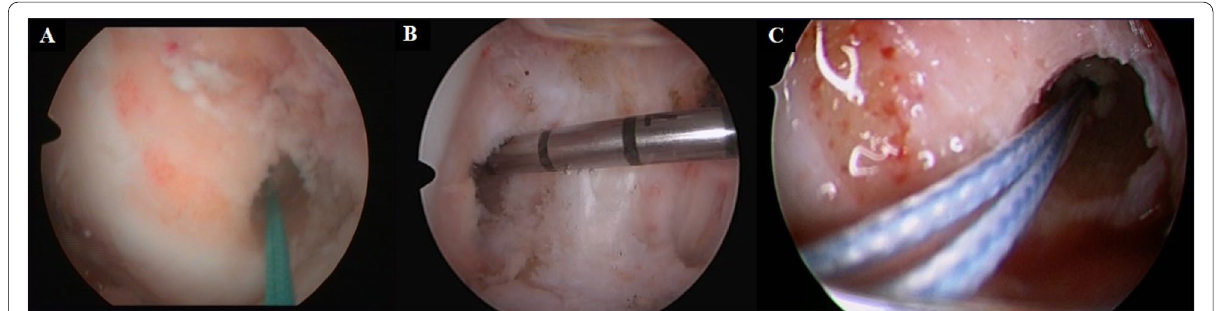
Fig. 4 Anatomic femoral tunnels in 3 patients ( A ), ( B ), ( C ), arthroscopic